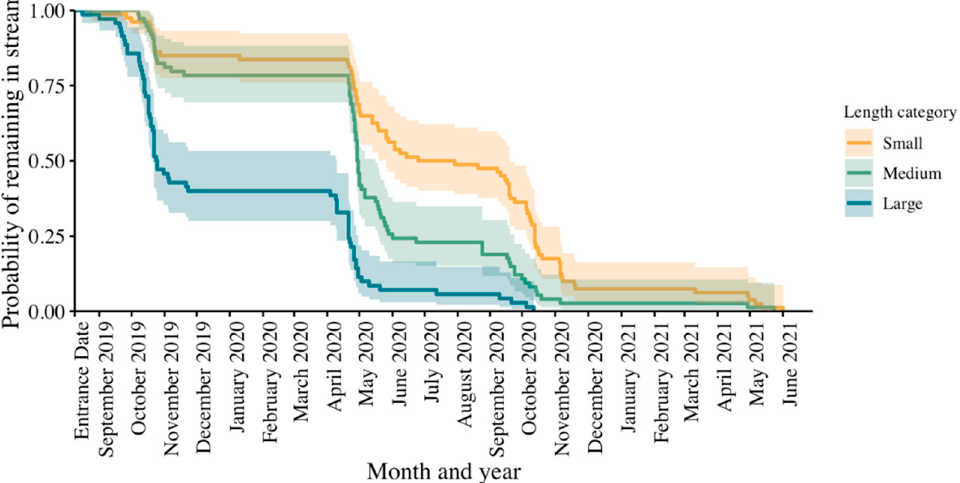
Figure 3. Probability of remaining in Graves Creek, Montana, for juvenile bull trout from the 2018 year-class, with color delineating three size categories based on the length at time of summer electrofishing, small (TL (mm): 100–110, n = 70), medium (TL (mm): 111–118, n = 74), large (TL (mm): 119–138, n = 80), and associated 95% confidence interval.